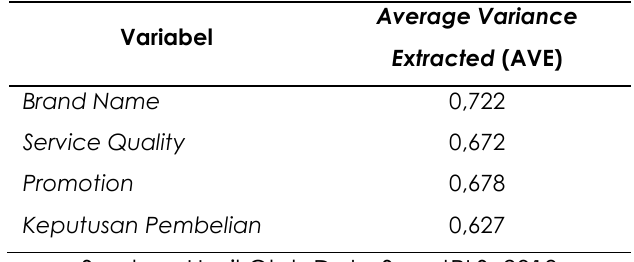
Tabel 4. Average Variance Extracted (AVE)